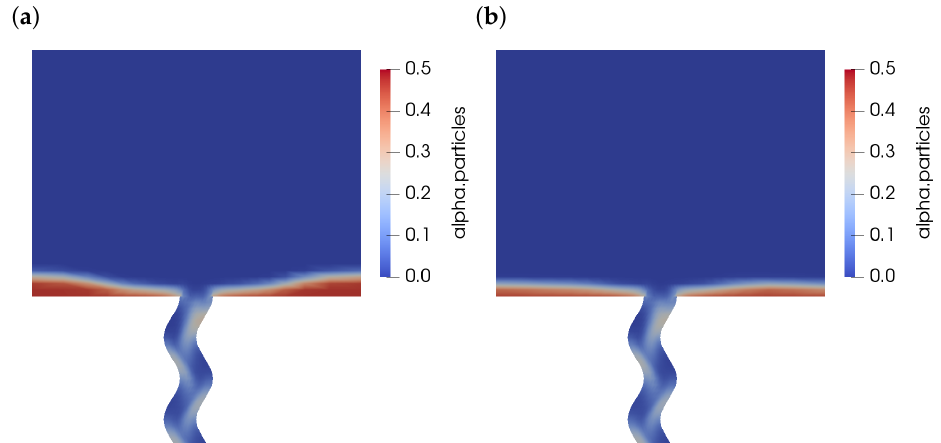
Figure 8. Effect of manipulation sequence on the volume fraction field. ( a ) W = 1mm at t = 8s, no vibration, no manipulation; ( b ) W = 1mm at t = 8s, no vibration, θ = 10 ◦ , ω =